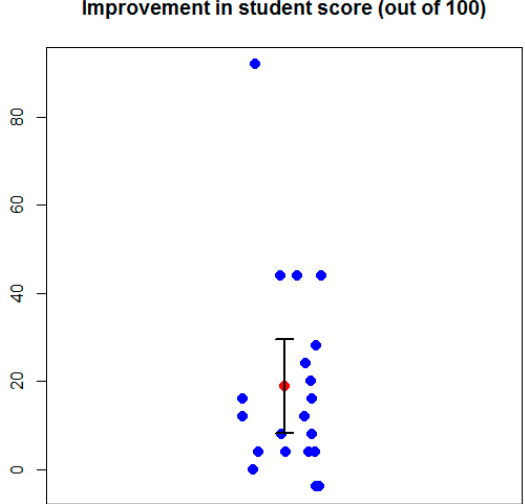
Figure 3. Change in student score on the assessment from the start to the conclusion of the genome annotation course. Each blue point represents a student, the red point represents the mean, and the 95% confidence interval is shown in black.